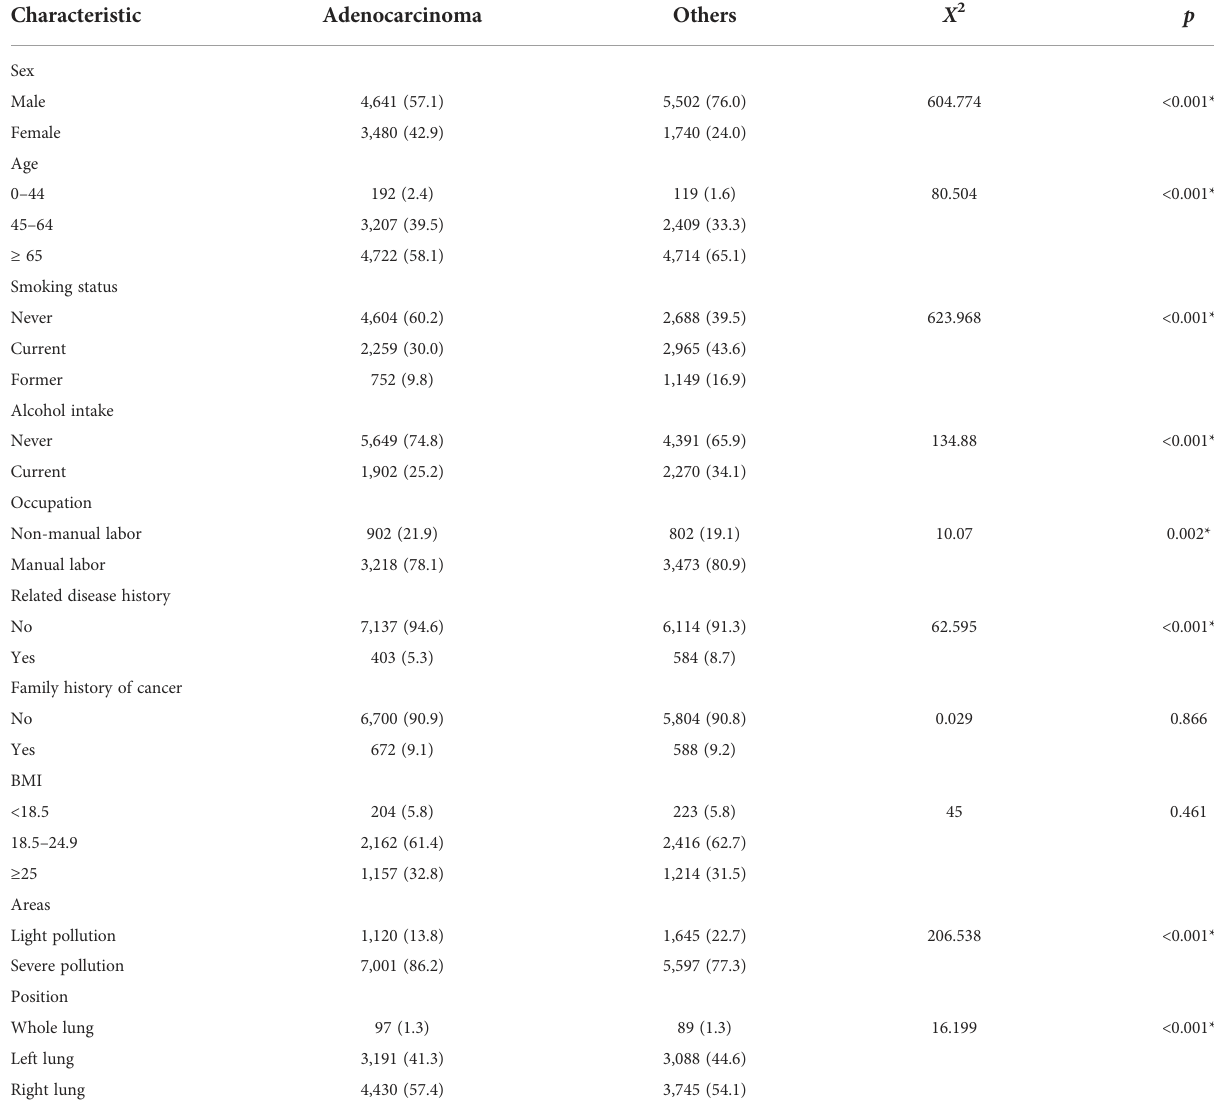
TABLE 2 Distribution of clinical characteristics in patients with lung adenocarcinoma (%) in Hebei Province, 2010 – 2017.